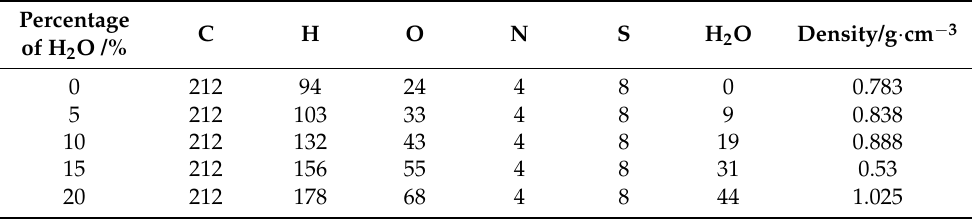
Table 1. Elemental compositions of the five simulation models. The numbers represent the number of atoms of each element in all simulation